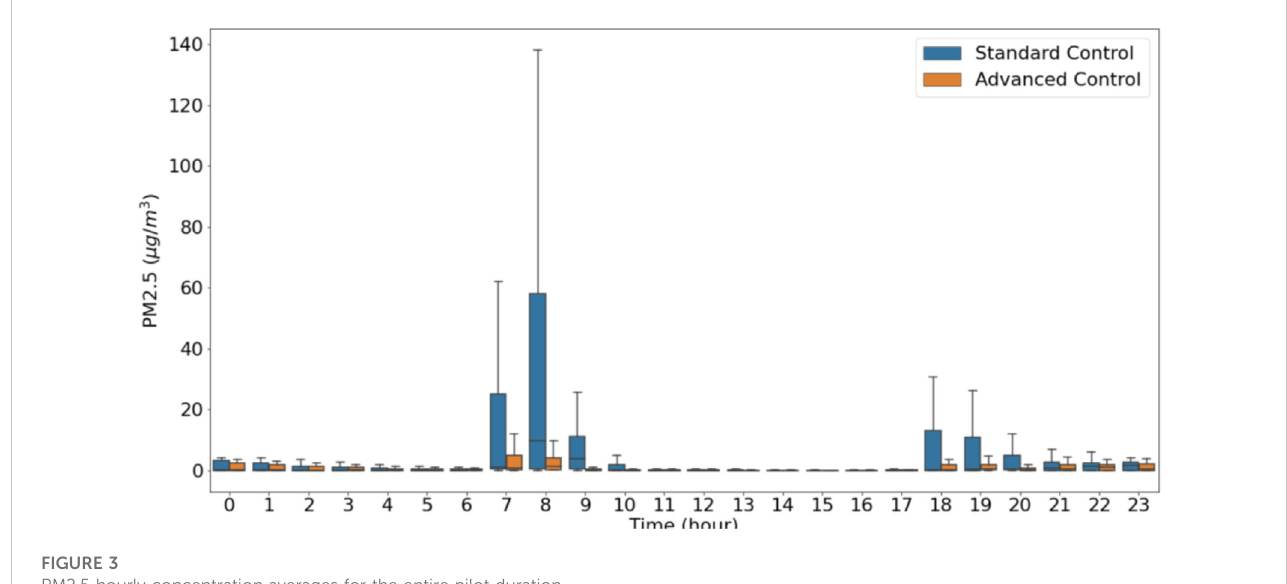
FIGURE 3 PM2.5 hourly concentration averages for the entire pilot duration.